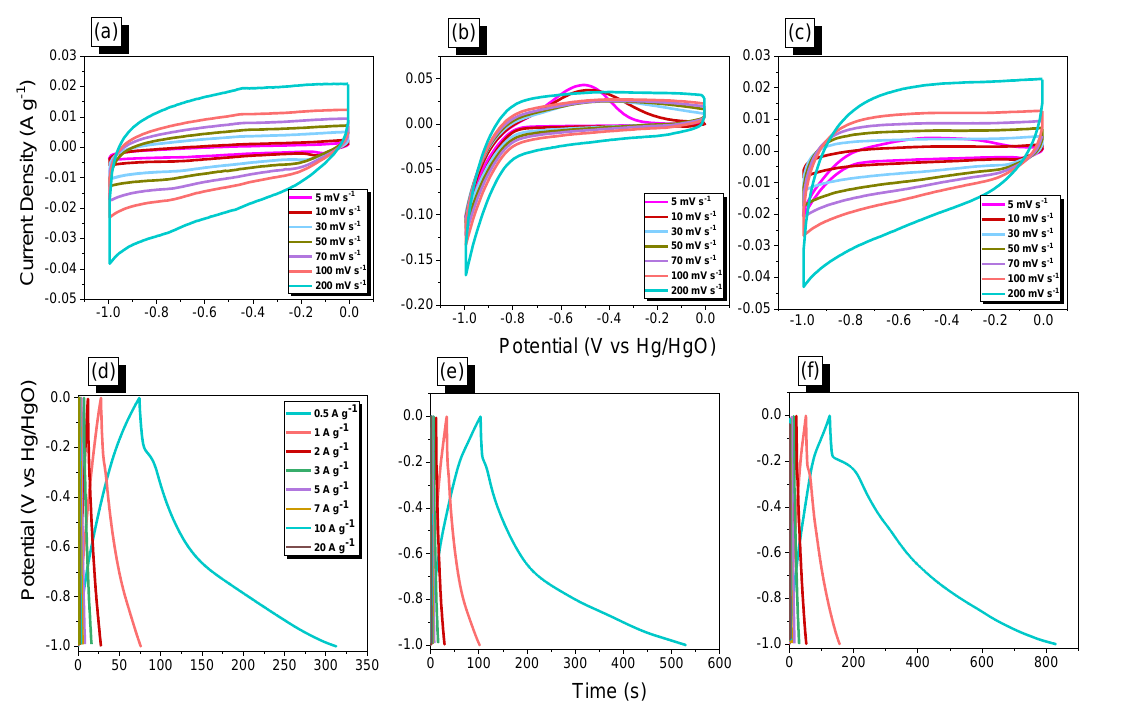
Figure 7. ( a – c ) CV and ( d – f ) GCD traces of the ( a , d ) POSS-OXD, ( b , e ) POSS-Th, and ( c , f ) POSS-TPTh POIPs.